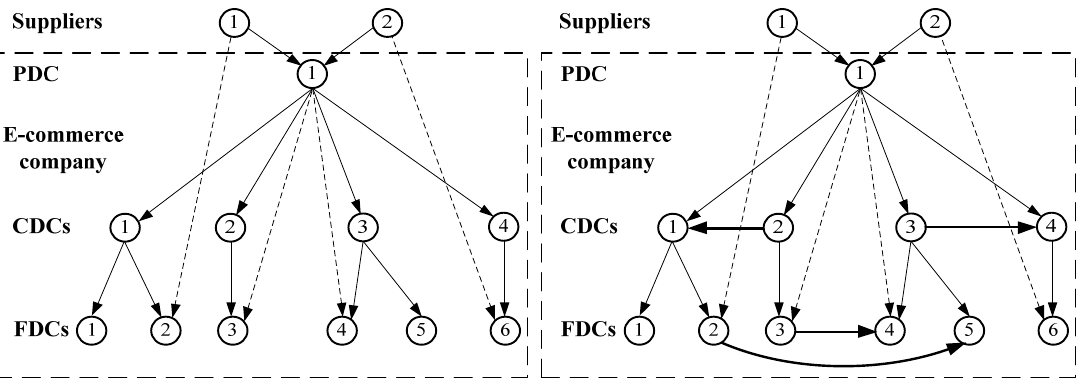
Figure 5. A distribution system without and with horizontal replenishments.